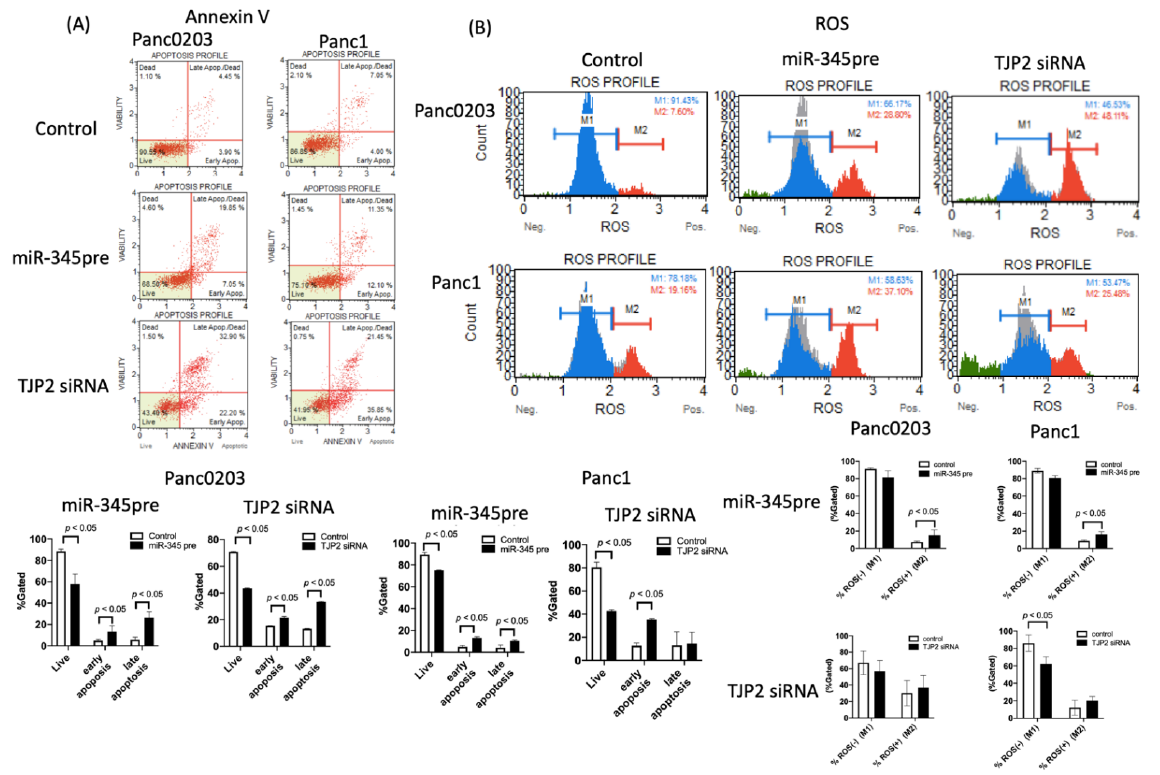
Figure 4. Function analysis under miR-345 overexpression or TJP2 suppression in Panc0203 and Panc1 cells. ( A ) Annexin V analysis for the detection of apoptosis in Panc0203 and Panc1 cells under transfected with miR-345pre and TJP2 siRNA. ( B ) Dynamics of reactive oxygen species in Panc0203 and Panc1 under transfected with miR-345pre and TJP2 siRNA. Blue peaks indicate ROS negative (M1 peak) and red peaks indicate ROS positive (M2 peak). Gray shadows indicate negative controls.